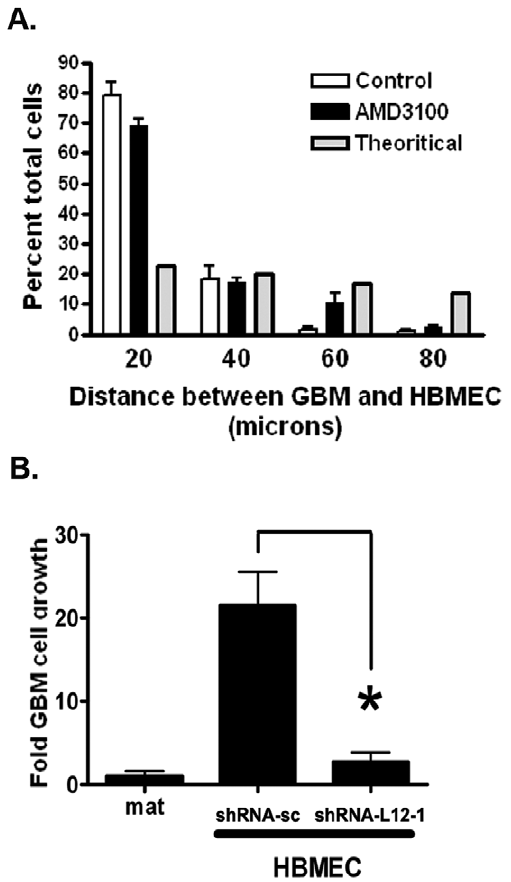
Figure 6. The chemotactic and trophic effect of the peri- endothelial space on primary GBMs is blocked by pharmaco- logic or genetic inhibition of the CXCL12-CXCR4 pathway. ( A ) The distance between GFAP positive GBM cells and mCherry fluorescent protein-expressing HBMECs in co-culture was measured as in Figure 3. Error bars represent SEM from three independent experiments involving three different GBM isolates. Approximately 100 GBM (GFAP positive) cells were counted in each condition. Nearly 80% of the GFAP positive GBM cells in the culture were within 20 microns of an endothelial cell. Treatment with AMD3100 resulted in a reduction in the proportion of GBM cells in closest proximity to endothelial cells and an increase in the proportion of cells at greater distances. P , 0.005 by two- way ANOVA. ( B ) Primary GBM cells co-cultured with HBMECs expressing a scrambled shRNA (sh-RNA-sc) show increased growth after 72 hours in culture, as measured by number of GFAP-positive tumor cells, compared to growth on Matrigel alone. The trophic effect of HBMECs on primary GBM cells is abrogated upon depletion of CXCL12 expression. N=3, *=P , 0.005 as determined by one-way ANOVA with Dunnett’s post-test for multiple comparisons.